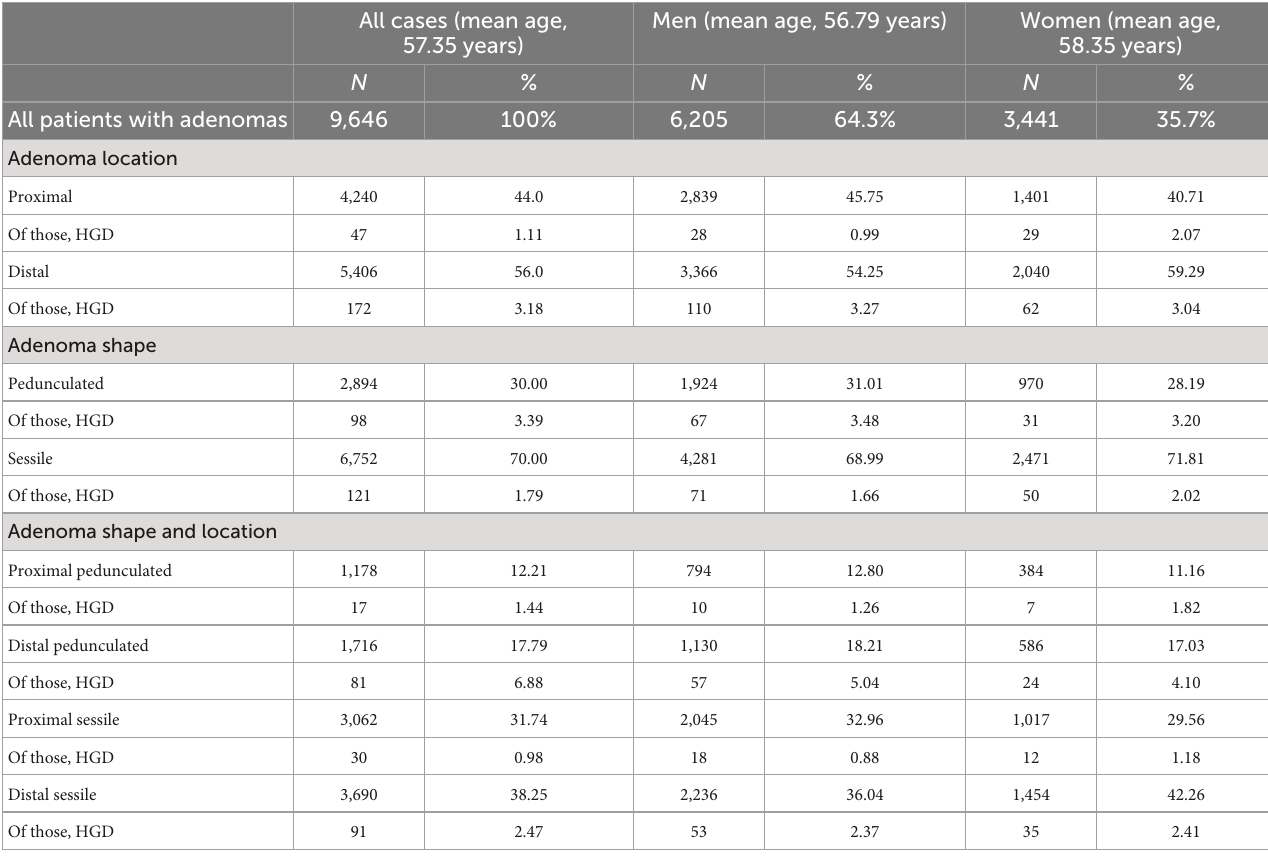
TABLE 6 Sex distribution of adenoma location and shape.